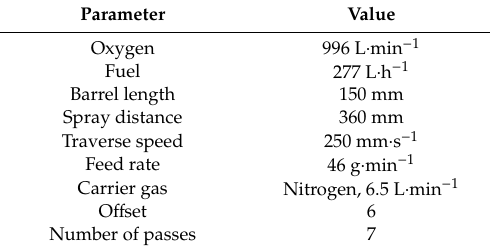
Table 4. Spray parameters.